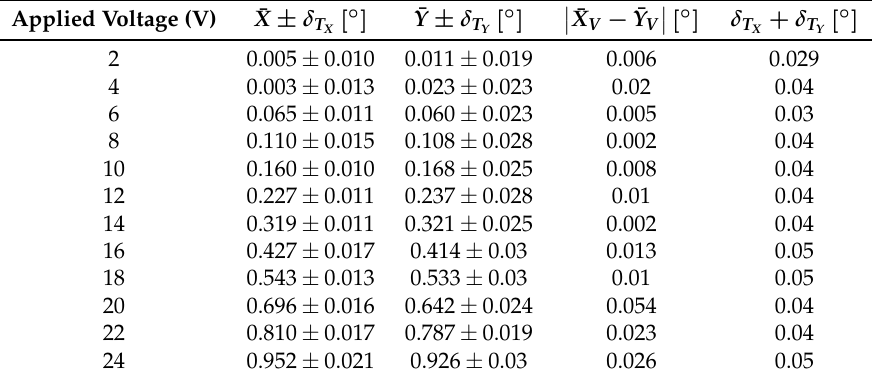
Table 5. Applied voltage vs parameters differences.